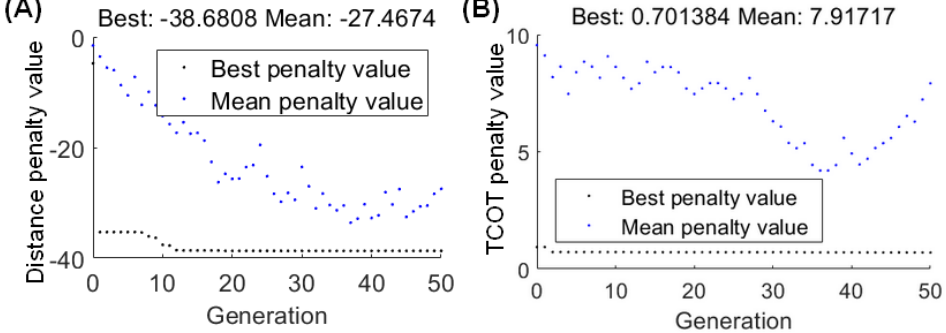
Figure 7. Optimal results of the genetic algorithm. ( A ) Walking distance. ( B ) Mechanical cost of transport.